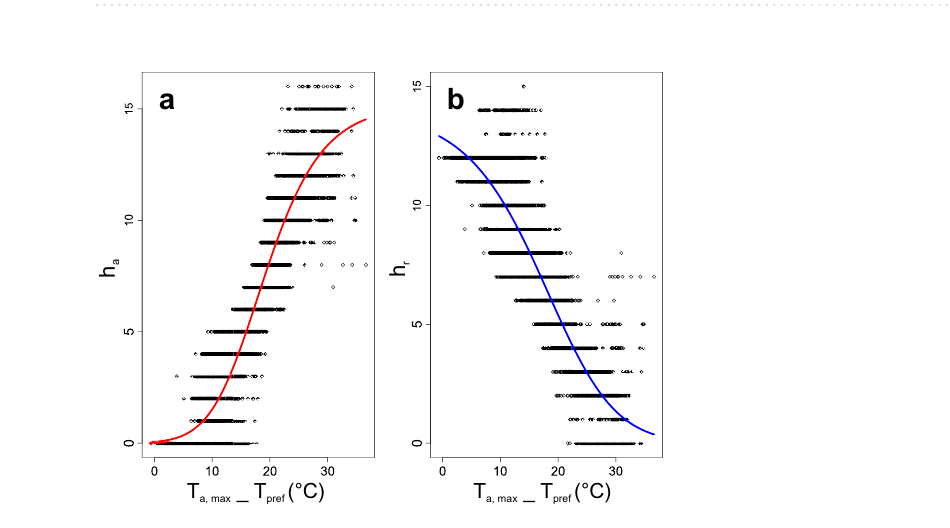
Figure 4. Richard´s Curve. Dependence of hours of activity (h a , panel a) and hours of restriction (h r , panel b) on daily maximum air temperature (T a, max ) of Liolaemus montanezi along the